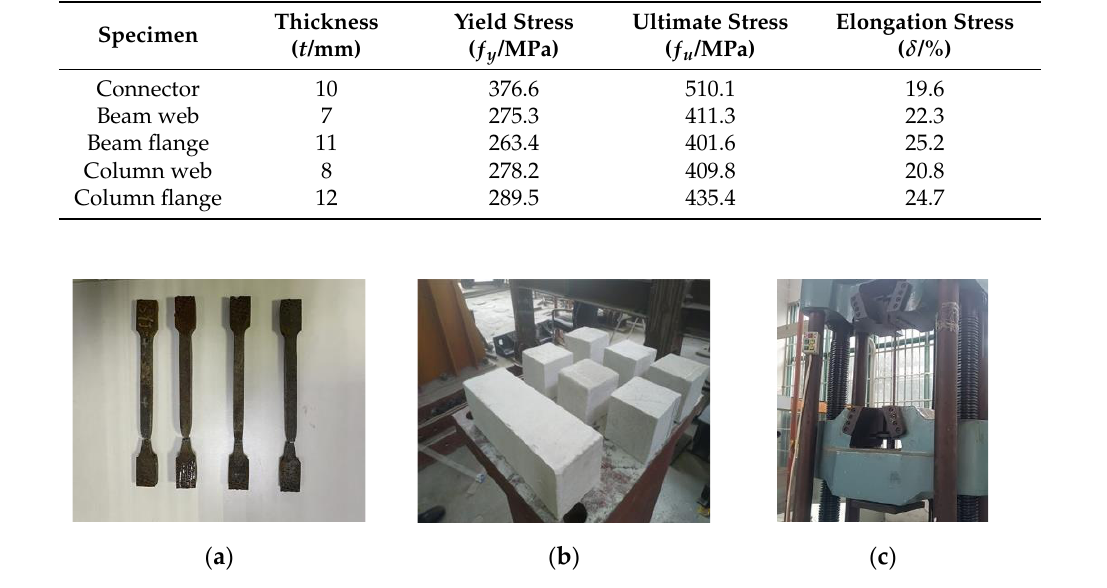
Figure 1. Details of the material properties test. ( a ) Tensile coupons; ( b ) ALC blocks; ( c ) universal hydraulic testing machine. Table 1. Material performance test results.